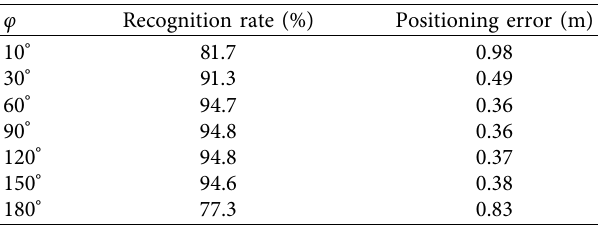
Table 3: Influence of the phase shift threshold φ on the experi- mental results.